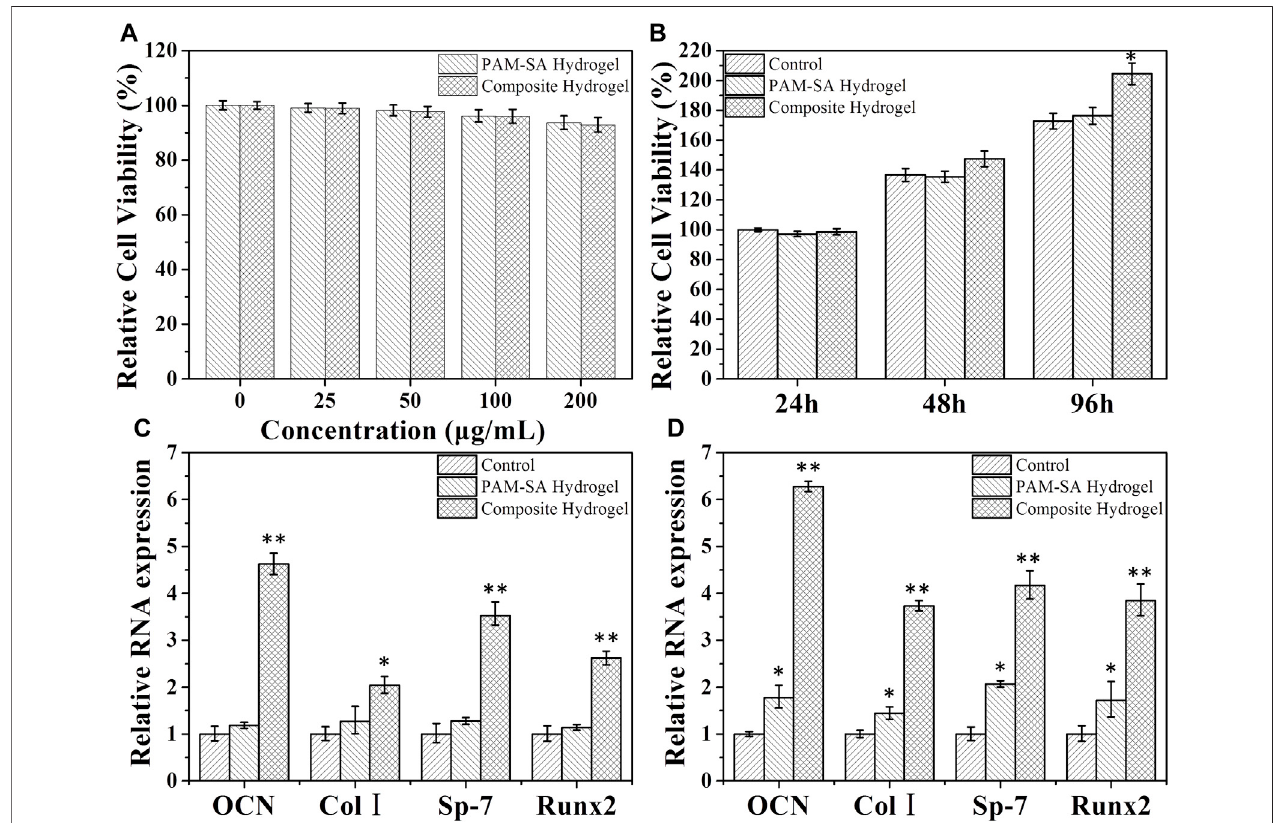
FIGURE 3 | (A) Different concentrations of the hydrogel solution were obtained by placing different masses of the hydrogel in the culture medium. The cytotoxicity after a 24 h co-culture with rBMSCs was calculated. (B) The proliferation of rBMSCs co-cultured with different hydrogels for 24, 48, and 96 h in hypoxia (2% O 2 ). The normalized osteoblastic gene expression of rBMSCs after incubation with different hydrogels in hypoxia (2% O 2 ) for 7 days (C) and 14 days (D) .